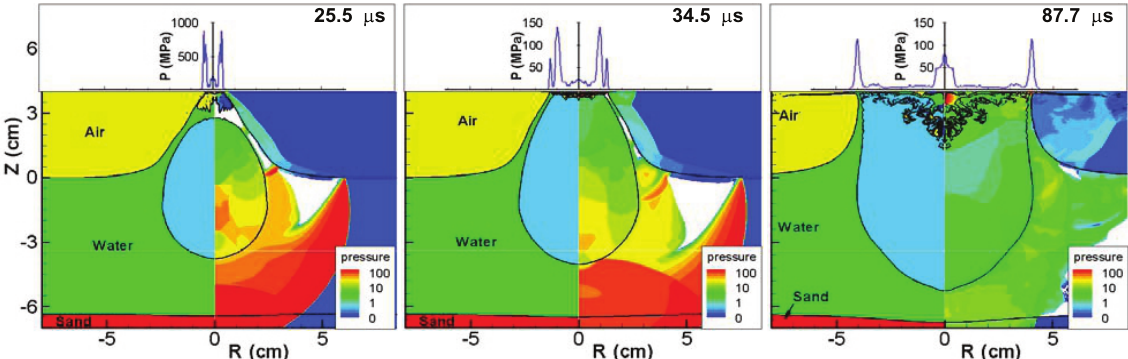
Fig. 10. Flow field development for a charge depth of 1 cm and plate sand-off of 4 cm.